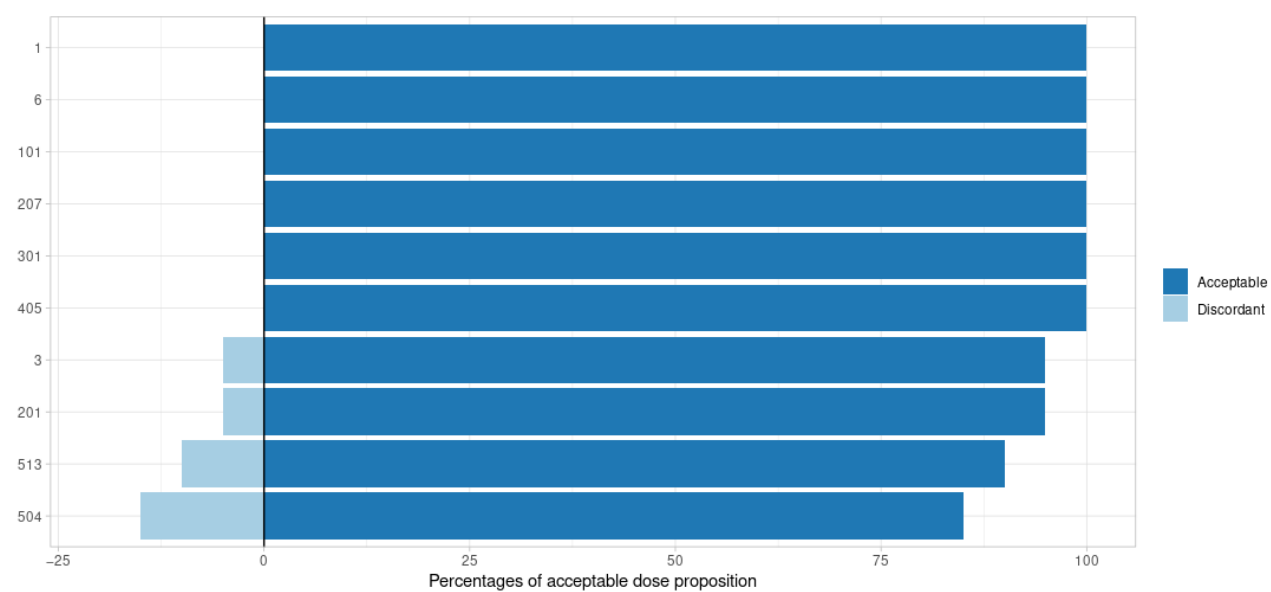
Figure 4. Density plots of the posterior distributions of 𝜂 𝑖 for subject #1 with model #003.mcmc, the MCMC algorithm implemented in posologyr; mlx, the MCMC algorithm of Monolix; sir, the SIR algorithm of posologyr; Cl, clearance; Ka, absorption rate; Vc, central volume of distribution; ALAG, lag-time. 4. Discussion A free and open-source software has been developed to allow for the Bayesian indi- vidualization of treatments. The performance of posologyr for individual parameter esti- mation was benchmarked against NONMEM for MAP point estimates and against Mon- olix for the estimation of full posterior distributions of individual parameters.